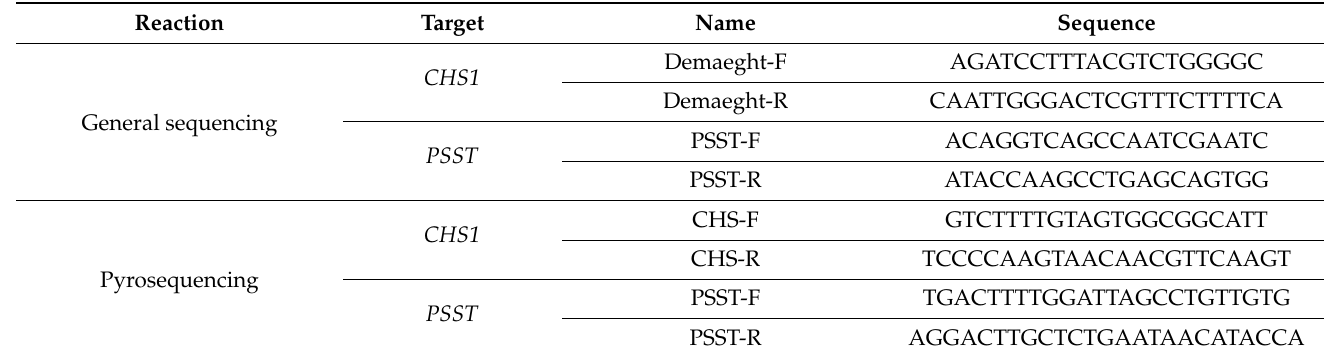
Table 2. Primers used for PCR